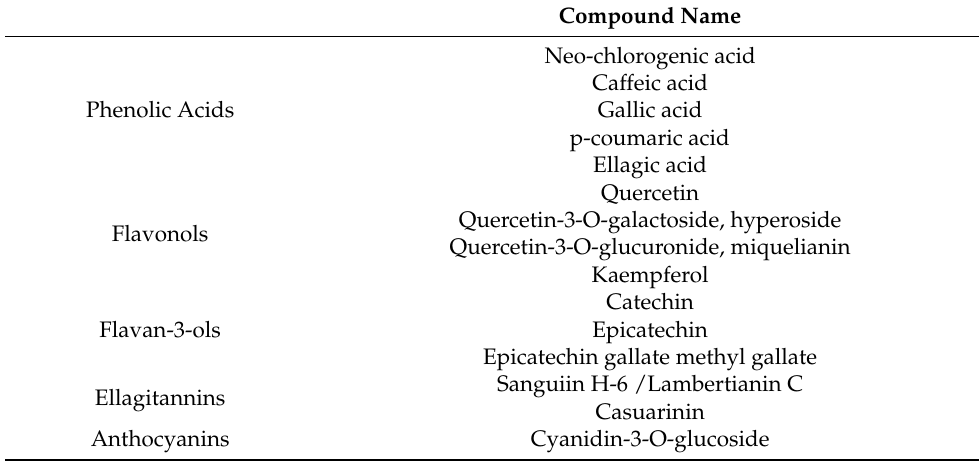
Table 1. An overview of the distribution of polyphenols compounds